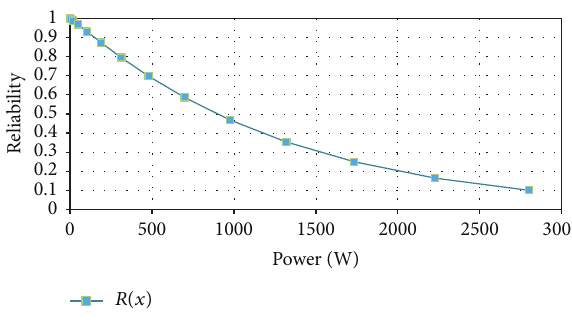
Figure 9: Reliability versus power.